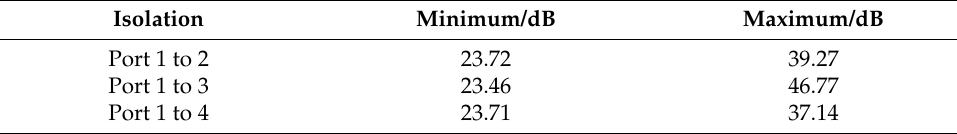
Table 2. The simulated isolation of the proposed UWB MIMO